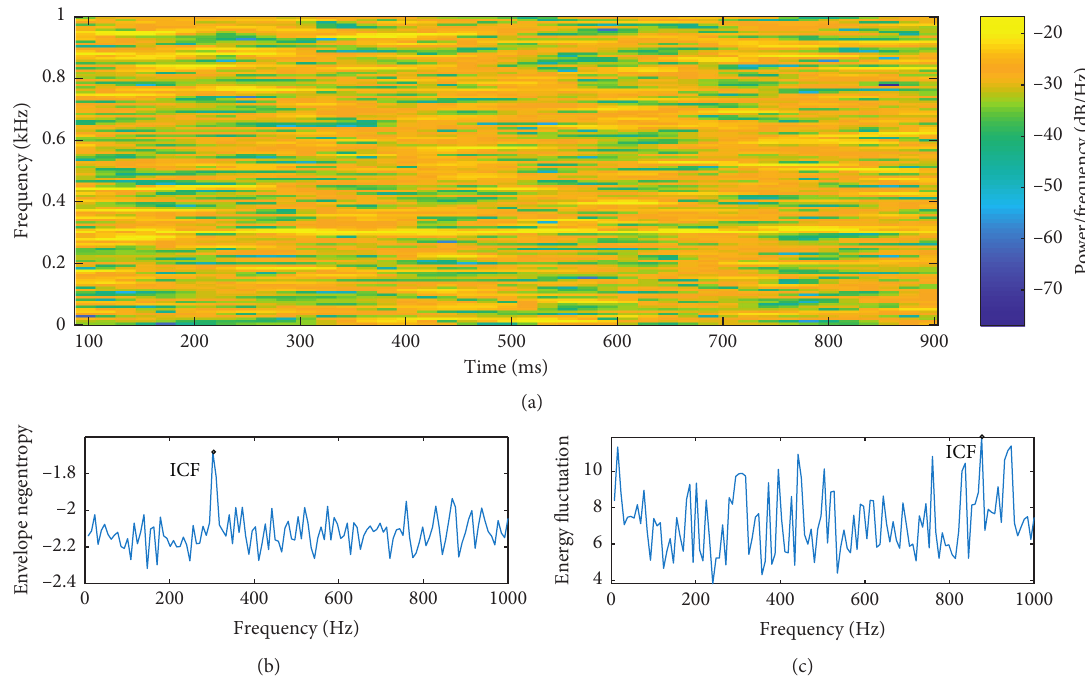
Figure 9: Spectral analysis of the simulated signal in Figure 6(b) at window length 384 and overlap rate 90%: (a) TFR, (b) ENS, (c) EFS.